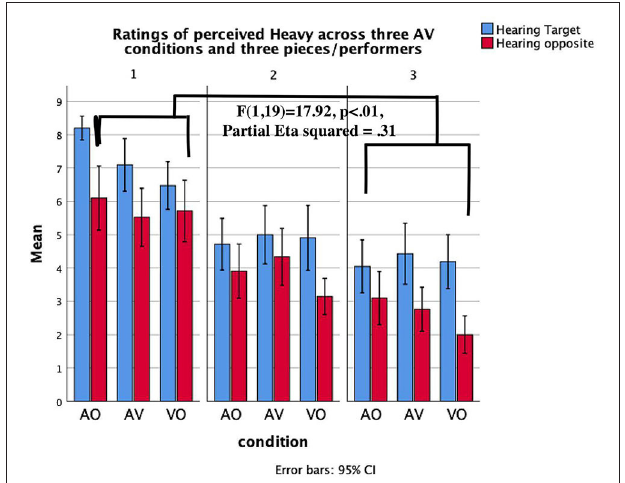
FIGURE 6 | Mean values of the evaluation of Heavy timbre across three pianists / pieces and AV stimuli. Error lines represent confidence intervals.